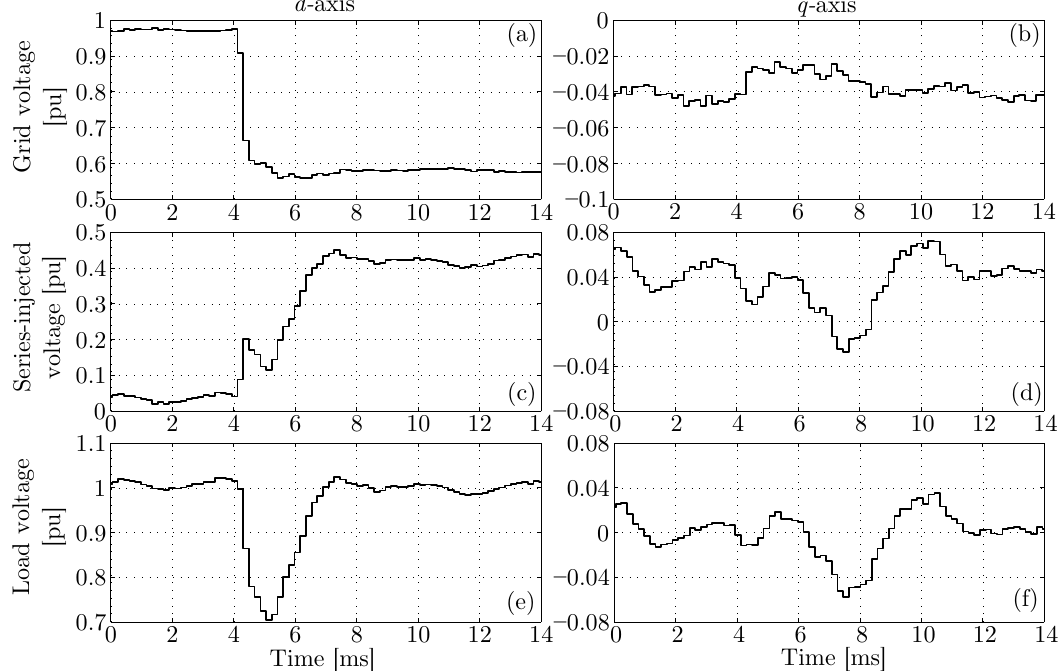
Figure 14. Experimental results. Mitigation of a 60% retained-voltage sag with an SF controller using in-phase compensation (signals referred to a synchronous reference frame (SRF)). ( a ) d - and ( b ) q -axis grid voltage, ( c ) d - and ( d ) q -axis series-injected voltage, and ( e ) d - and ( f ) q -axis load